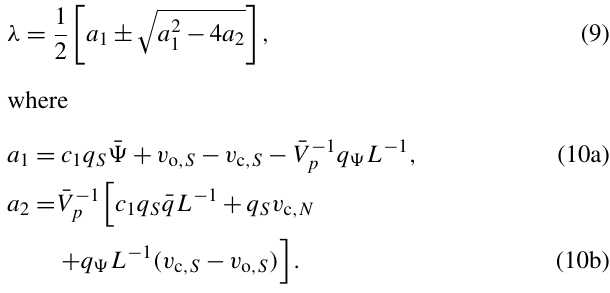
Table 1. Parameter values common to all calculations except those in Fig. 12, for which (cid:57) 0 = 1630Pam − 1 (corresponding to a